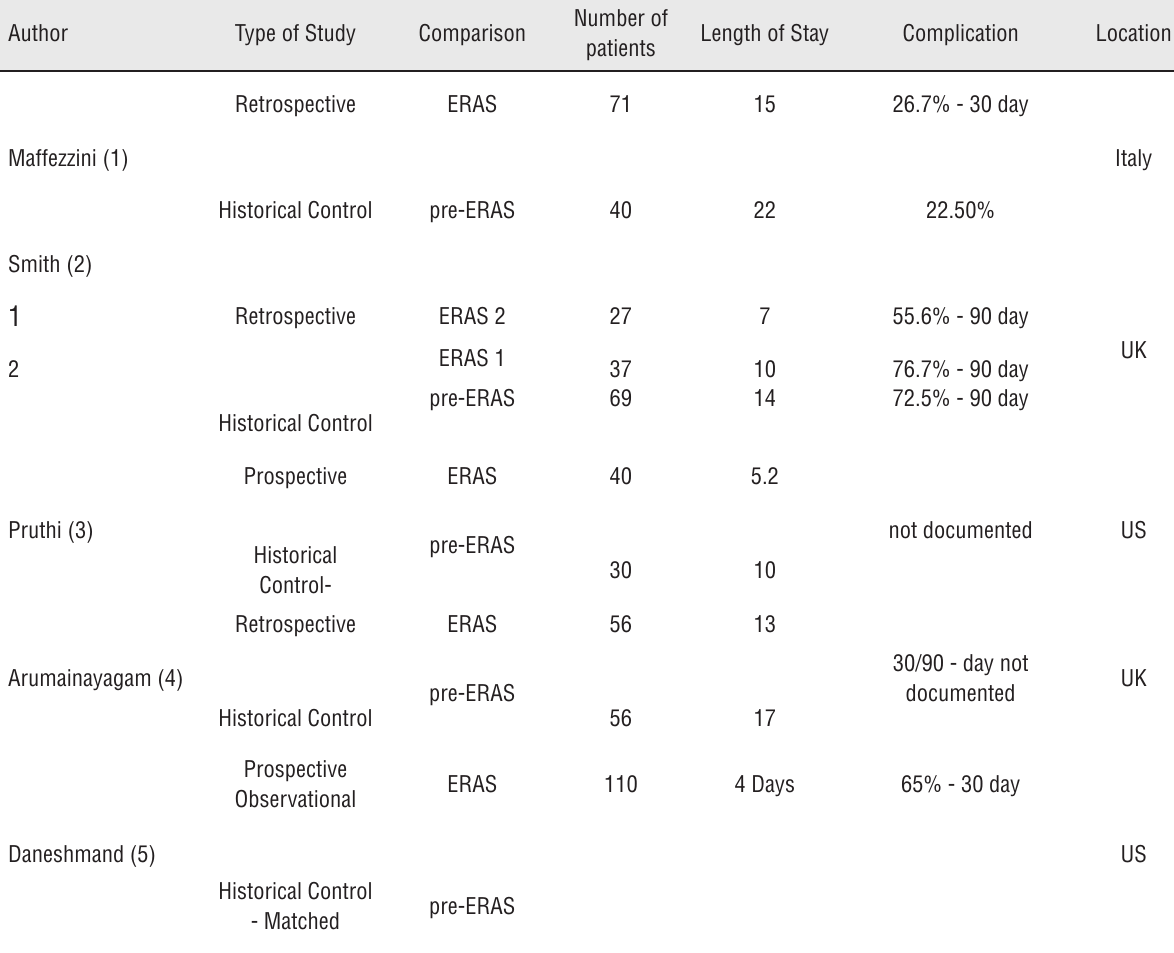
Table 1 - Enhanced recovery after surgery – radical cystectomy